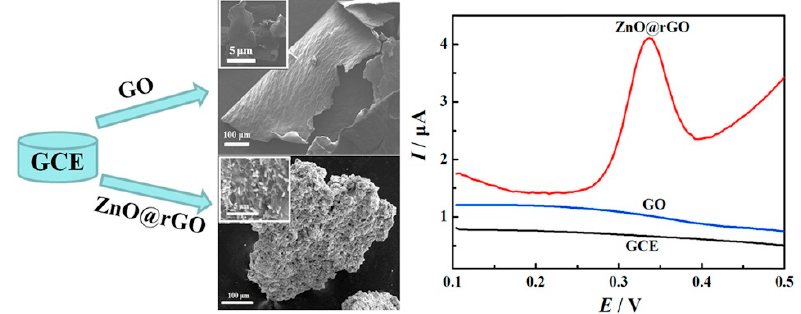
Figure 1. ZnO nanoparticles (ZnO@rGO) for the detection of o 8 dGuo. Reprinted with permission from Reference [26], © 2018, Elsevier.